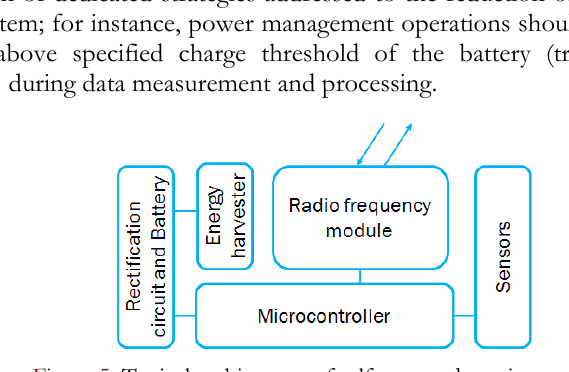
Figure 5: Typical architecture of self-powered sensing system.